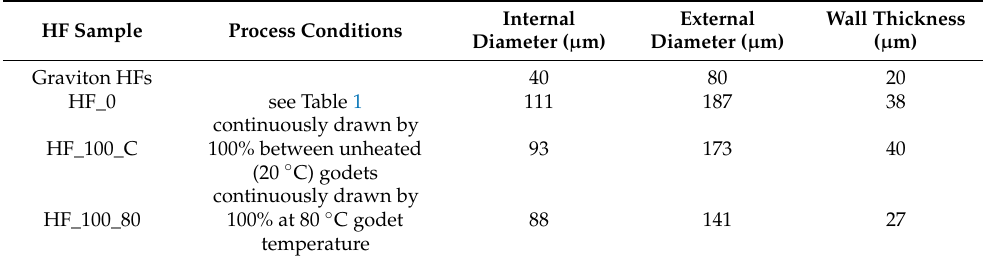
Table 2. Basic geometric dimensions of hollow fibers PMP.